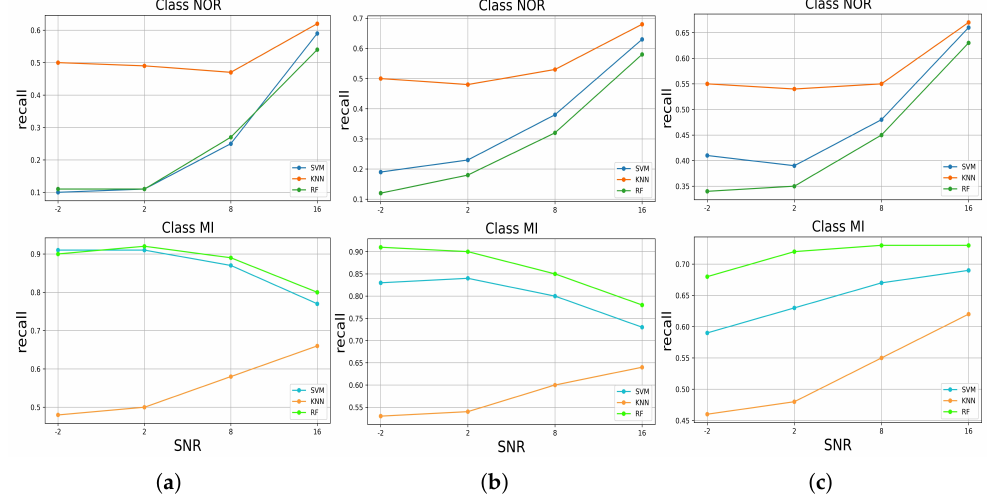
Figure 10. The recall performance of predicting the classes of the signal with added noises by the trained models, ( a ) for added muscle artifact noise, ( b ) for added electrode motion noise, ( c ) for added baseline wander